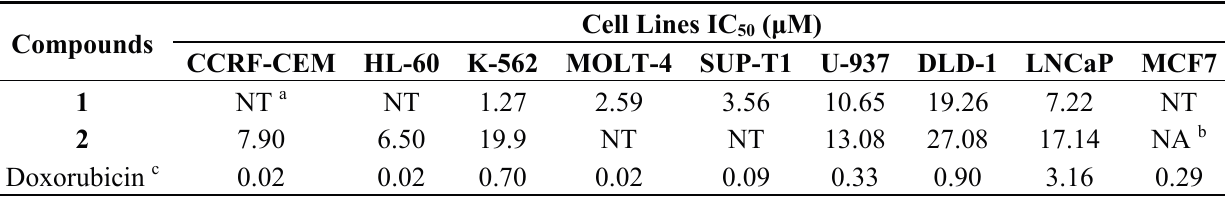
Table 3. Cytotoxic data of homoscalaranes 1 and 2